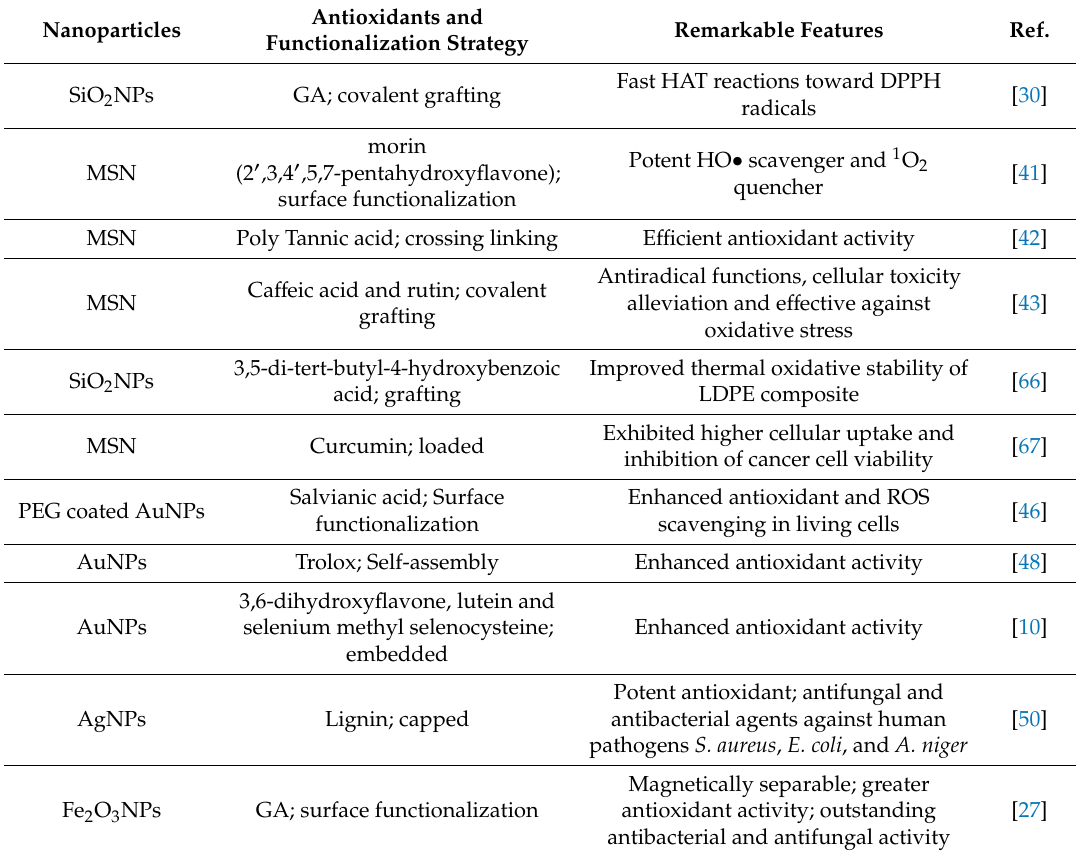
Table 1. Nanoantioxidants and their remarkable